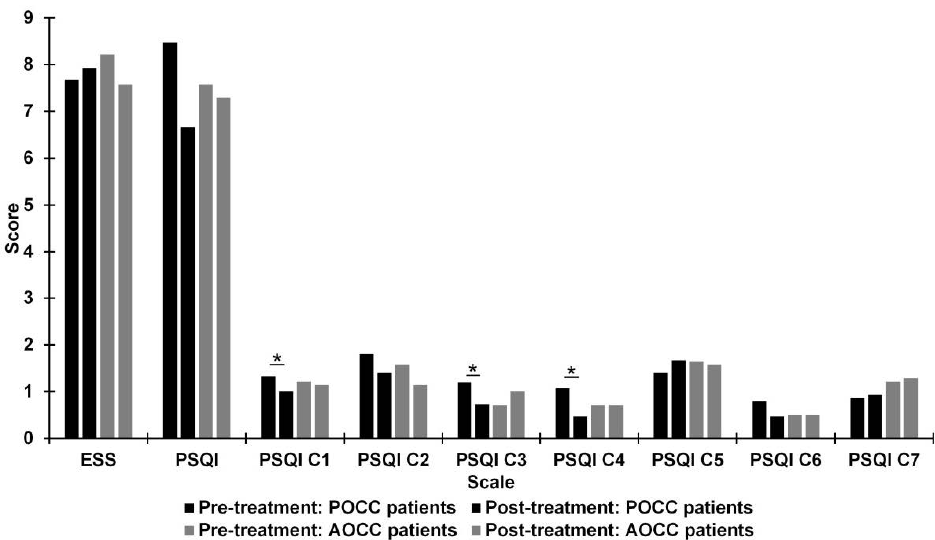
Figure 3. Differences between pre- and post-treatment in patients with presence of optic chiasm compression (POCC) and patients with absence of optic chiasm compression (AOCC) on Epworth Sleepiness Scale (ESS) scores and Pittsburgh Sleep Quality Index (PSQI) scores. PSQI: C1 = Sub- jective Sleep Quality; C2 = Sleep Latency; C3 = Sleep Duration; C4 = Sleep Efficiency; C5 = Sleep Disturbances; C6 = Use of Sleeping Medication; C7 = Daytime Dysfunction. * p < 0.05.